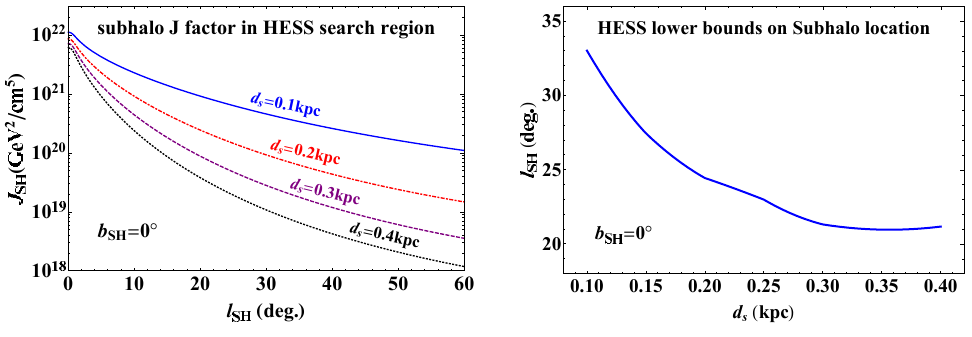
Figure 6 . Left panel: the subhalo J factor in the HESS search region as the function of l SH for di(cid:11)erent d s values. Right panel: HESS lower limits on l SH as a function of d s . Here l SH is the angle between the galactic center and the center of the